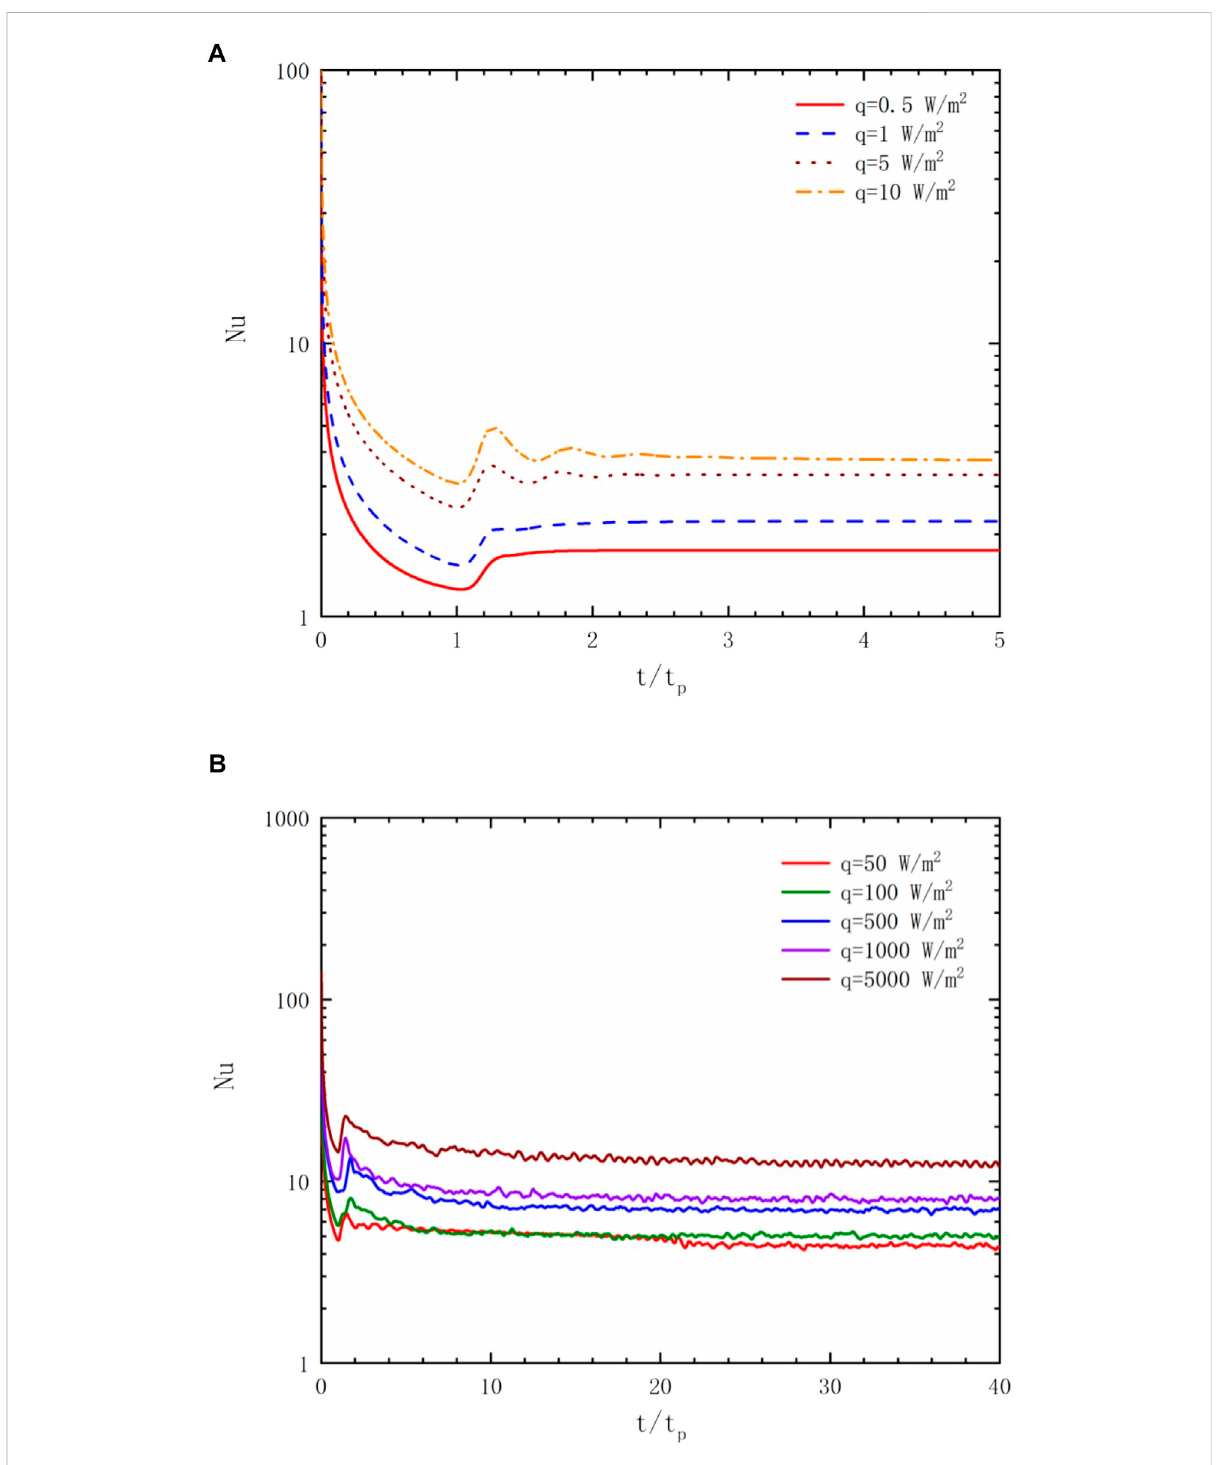
FIGURE 4 Variations of the horizontally averaged Nusselt number Nu with time evolution. (A) q = 0.5 — 10 W/m 2 . (B) q = 50 — 5000 W/m 2